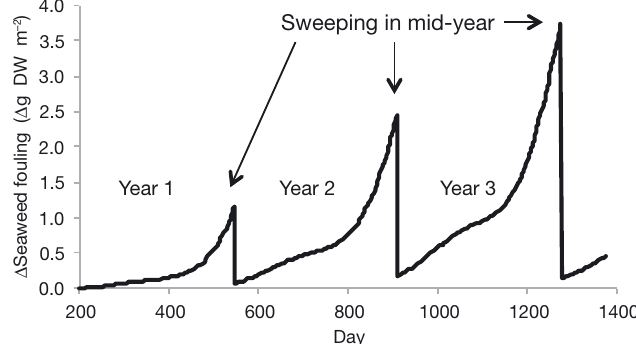
Fig. 10. Difference in seaweed fouling on predator nets at Chuckanut Shellfish farm for planted and fallow